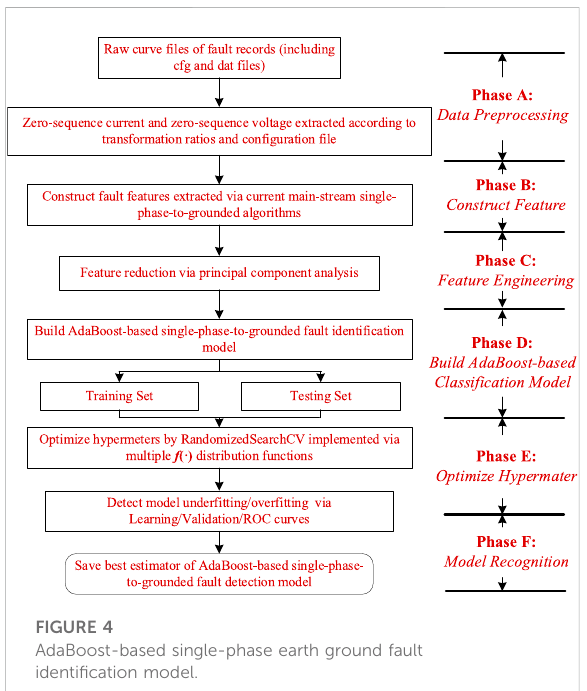
FIGURE 4 AdaBoost-based single-phase earth ground fault identi fi cation